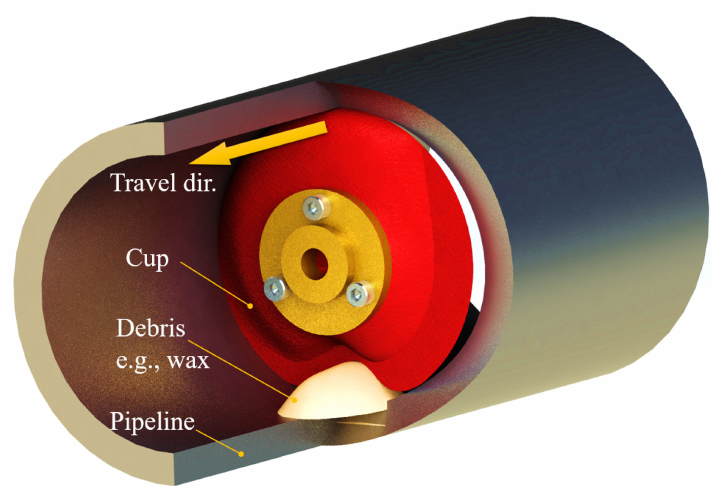
Figure 1. A typical scenario of Φ 100 mm PIG travelling in pipeline encountering wall-mounted